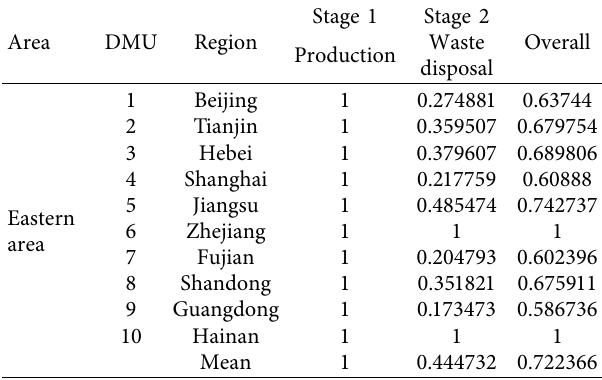
Figure 4: Sensitivity analysis of parameter w in efficiency evaluation of regions for country-wise evaluation. (a) Efficiency scores in stage 1. (b) Efficiency scores in stage 2. (c) Overall efficiency scores. Table 6: Area-wise efficiency evaluations results in the Eastern area.